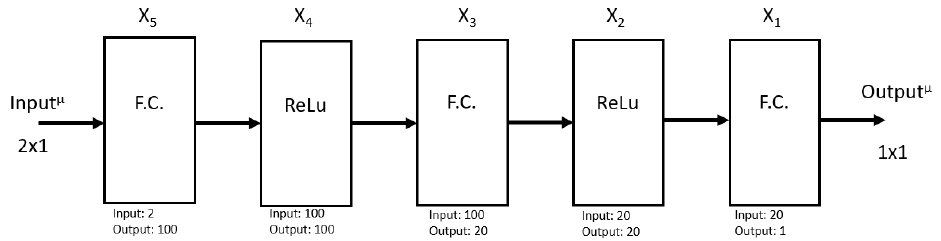
Figure 7. A simple representation of the created feedforward neural network.